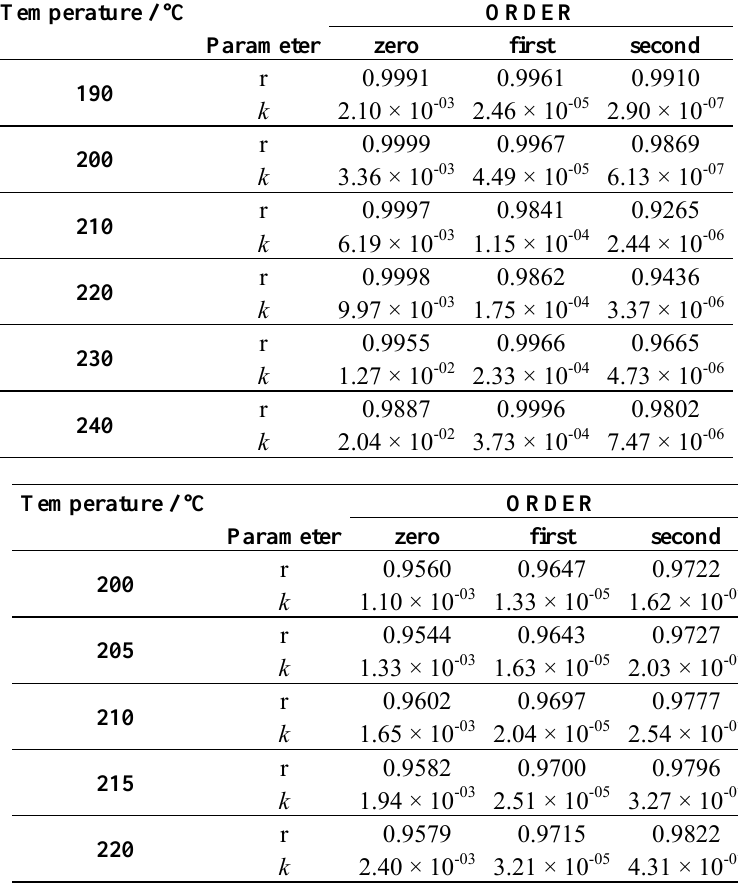
Table 1. Results of the mathematical models adjustment of zero, first and second order, with values of r (correlation coefficient) and k (reaction rate). (a) Drug (b) pharmaceutical